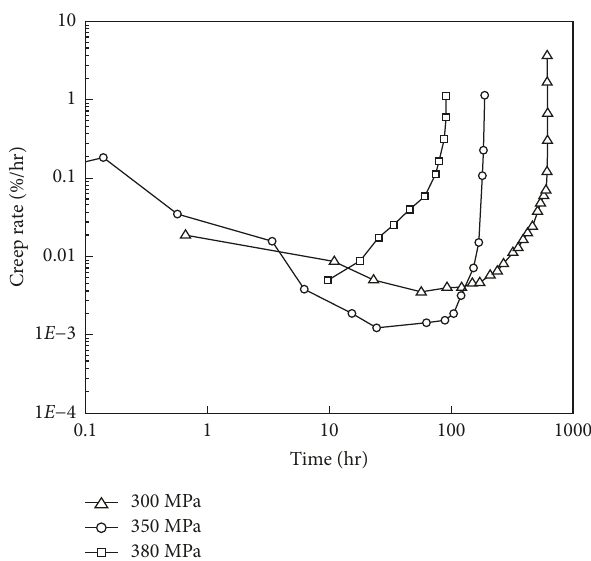
Figure 8: Creep rate as a function of time for cast Haynes 282 alloy at 750 ° C.